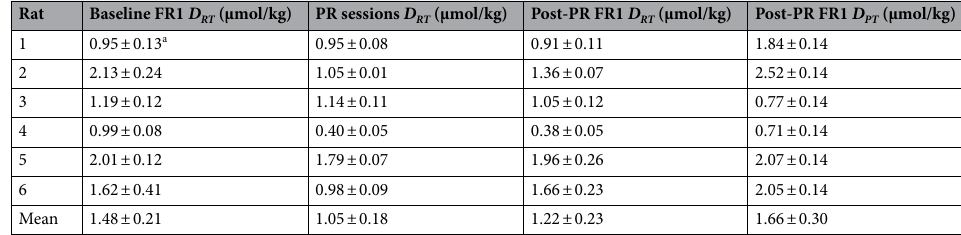
Table 2. Calculated D RT and D PT in individual rats. a Mean ± SEM.